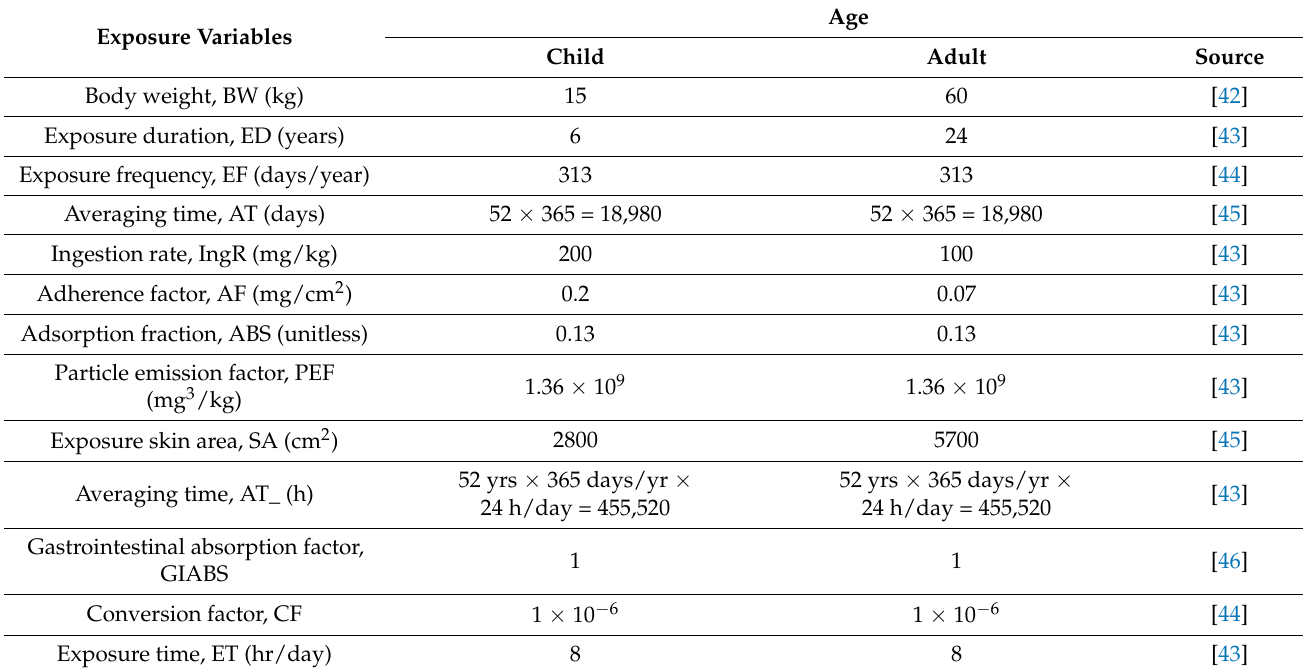
Table 1. Parameters for estimating human cancer